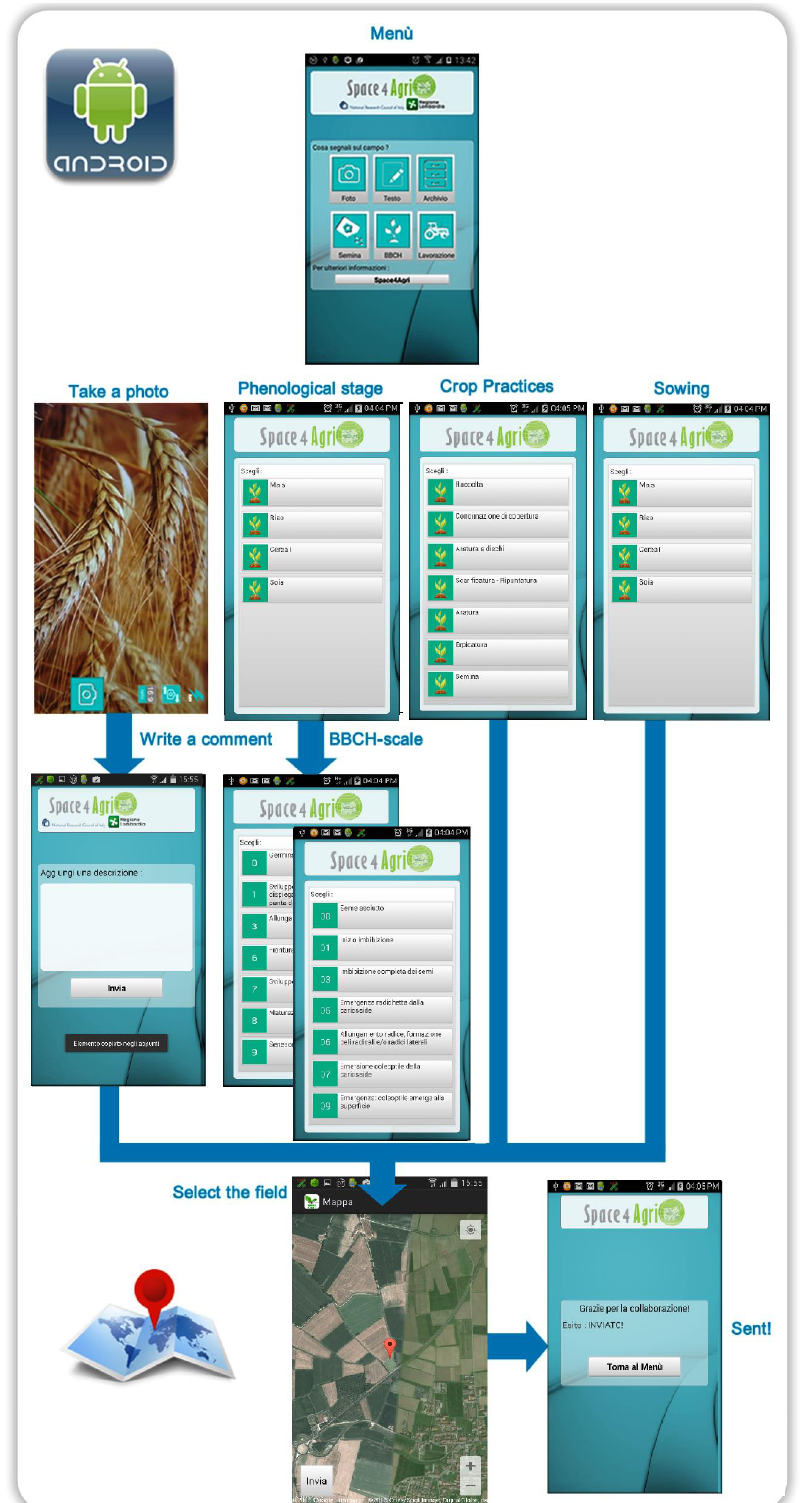
Figure 2. Workflow of the in-situ data created by means of the S4A Smart App.